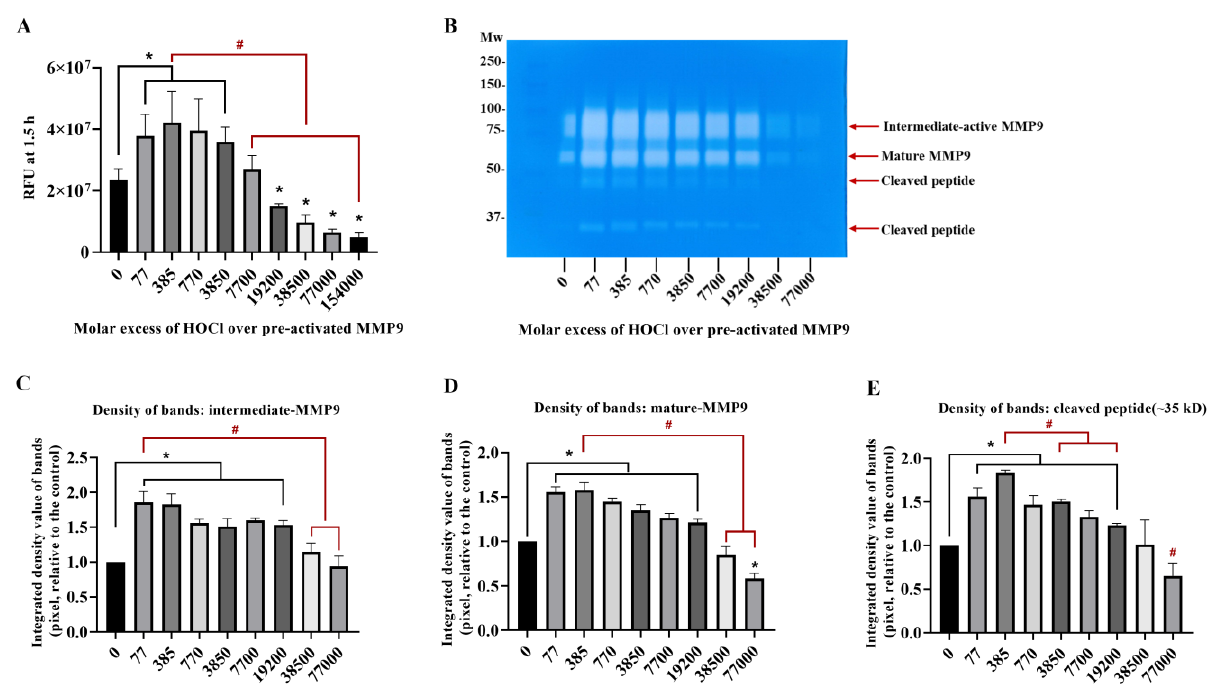
Figure 3. Fluorescence and zymography analyses of the effects of HOCl on preactivated MMP9. Commercial active MMP9 (13 nM) was mixed with increasing molar ratios of reagent HOCl (as indicated) in assay buffer for 24 h at 37 °C before assessment of activity using the fluorescence assay (Panel ( A )), as described in Section 2 and the legend to Figure 1, although with the activity assessed over 30 min at 1 min intervals. The activity of the samples was also examined using gel zymography (Panel ( B ); see Section 2). Panels C – E present the integrated image densities of the bands corre- sponding to the gels presented in Panel B, for the bands corresponding to active intermediate MMP9 (Panel ( C )), mature-form MMP9 (Panel ( D )) and cleaved peptide (Panel ( E )), assessed using ImageJ software. Quantitative data are presented as means ± SDs from three independent experiments. Sta- tistical analysis was performed using one- way ANOVA with Dunnett’s multiple comparisons test, with statistical significance (assumed at the p < 0.05 level) against the untreated group (0 µM) indi- cated by *, and against the 77- or 385-fold molar excesses of HOCl (the highest band intensities detected) indicated by #.